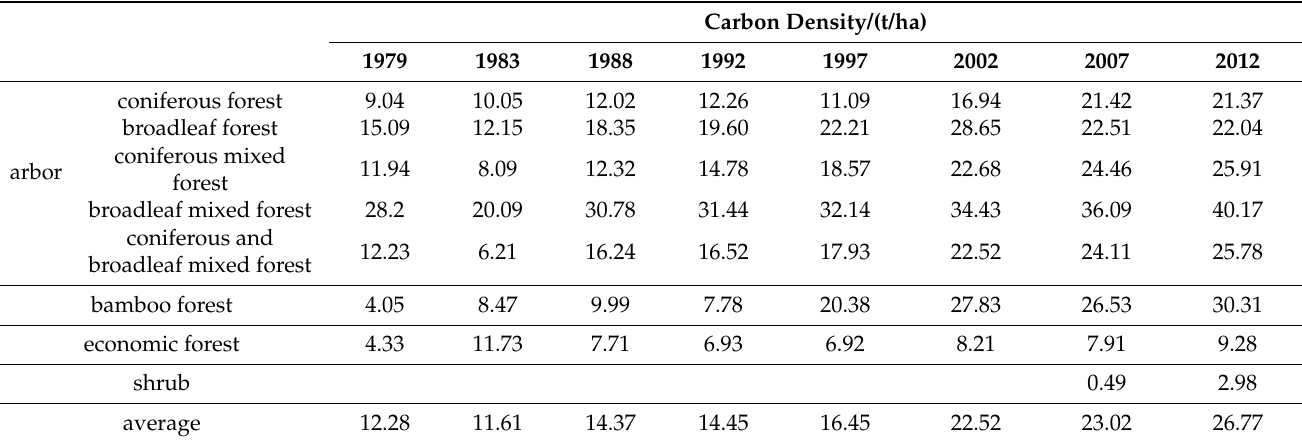
Table 3. Carbon density in Guangdong